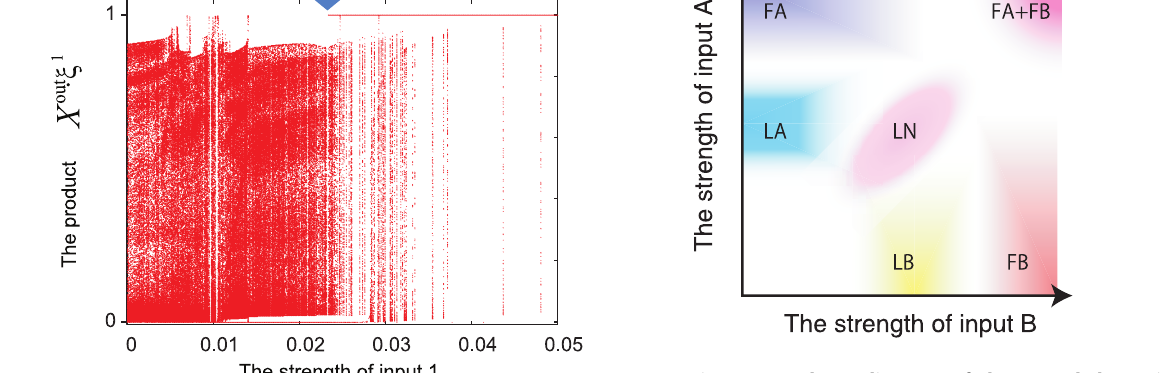
Figure 13. Phase diagram of the neural dynamics under the application of two inputs. After the model neural network learned several input-output relations, we applied the two learned inputs A and B with the strength g A and g B . By varying these two input strengths, we checked what type of attractors the neural dynamics are attracted to. Depending on the type of attractor, rough phase diagram is depicted. Each of the phases in the figure represents the following behavior; FA and FB: Only the fixed-point attractor with the output matching with the target A or B (FA) and target B (FB), respectively. FA + FB: Coexistence of the two fixed point attractors for the target A and B, reached depending on the initial condition. LA and LB: Limit-cycle attractor in which the neural dynamics approach the target A or target B, respectively. LN: novel limit cycle attractor in which the neural dynamics approach neither the target A nor target B. Shown here is a rough diagram, and actual bifurcations are more complicated, and also depend on each learning